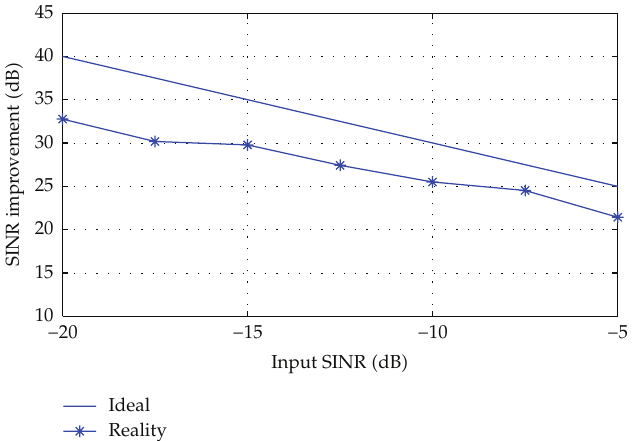
Figure 5: Comparison of the performance of the ideal and proposed multi-scale KF